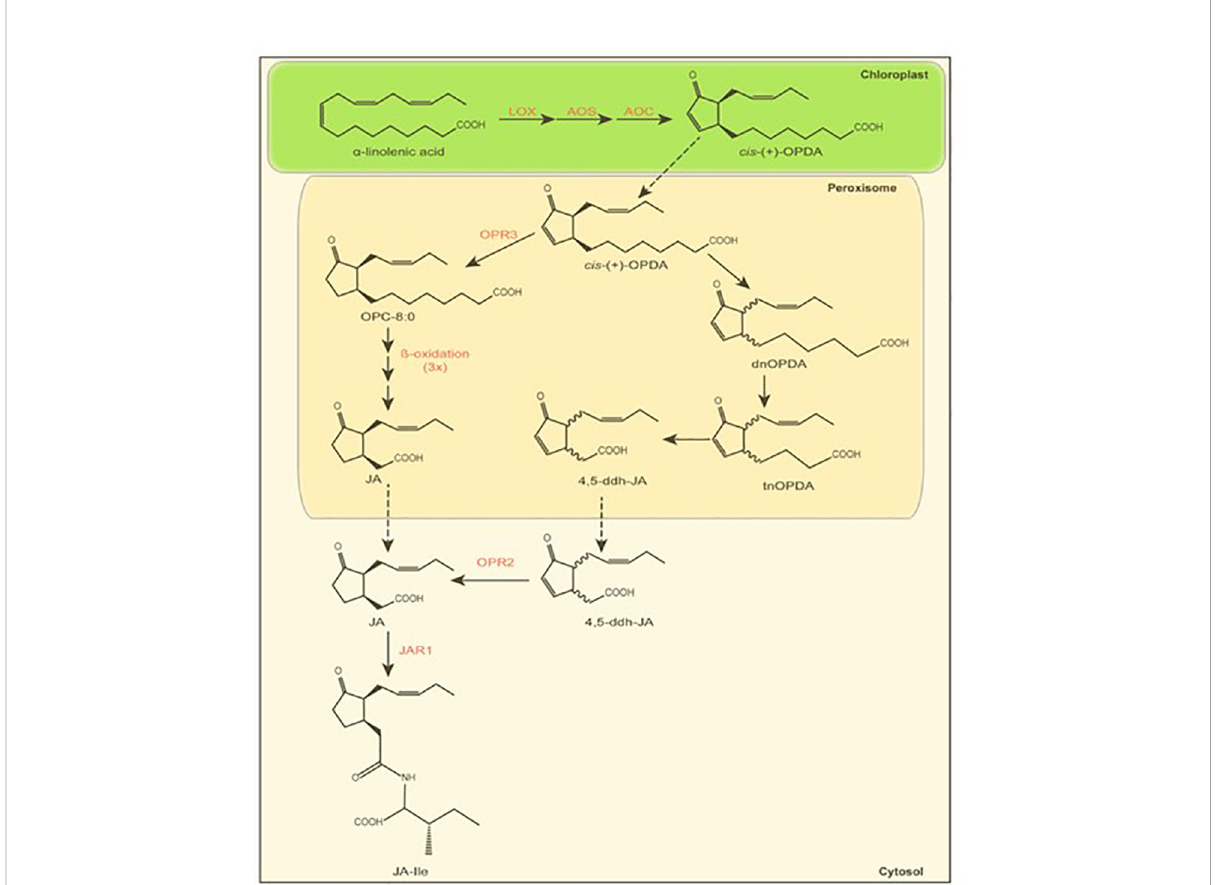
FIGURE 2 Jasmonate biosynthesis. Simpli fi ed scheme showing the generation of jasmonoyl-isoleucine (JA-Ile) via two alternative jasmonic acid (JA) pathways. Enzymatic reactions and corresponding enzymes are indicated in red. Transport between cell compartments is depicted by black dotted arrows. Abbreviations: LOX, Lipoxygenase; AOS, Allene Oxide Synthase; AOC, Allene Oxide Cyclase; OPDA, 12-oxo-phytodienoic acid; dnOPDA, dinor-OPDA; tnOPDA, tetranor-OPDA; 4,5-ddh-JA, 4,5-didehydro-JA; OPR, OPDA Reductase; OPC-8, 8-(3-oxo-2-(pent-2-enyl) cyclopentenyl)octanoic acid; JA, jasmonic acid; JAR, Jasmonate resistant; JA-Ile, jasmonoyl-isoleucine. Scheme modi fi ed after Chini et al. (2018) and Wasternack and Song